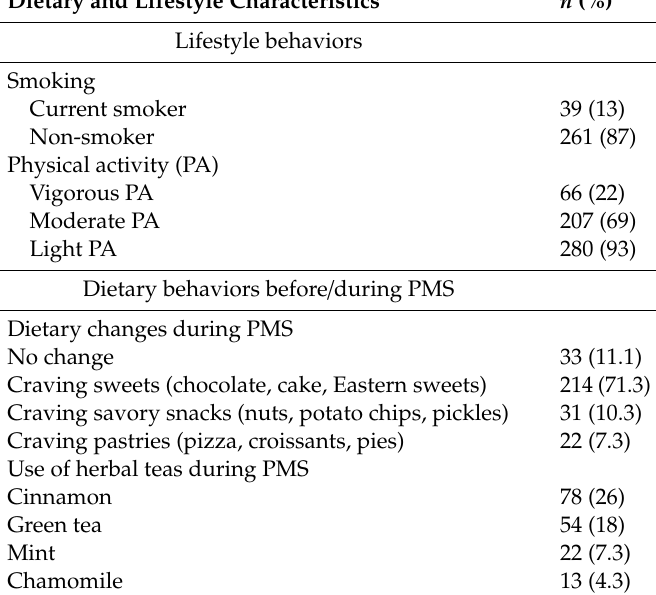
Table 2. Participants’ dietary and lifestyle characteristics ( n = 300). Dietary and Lifestyle